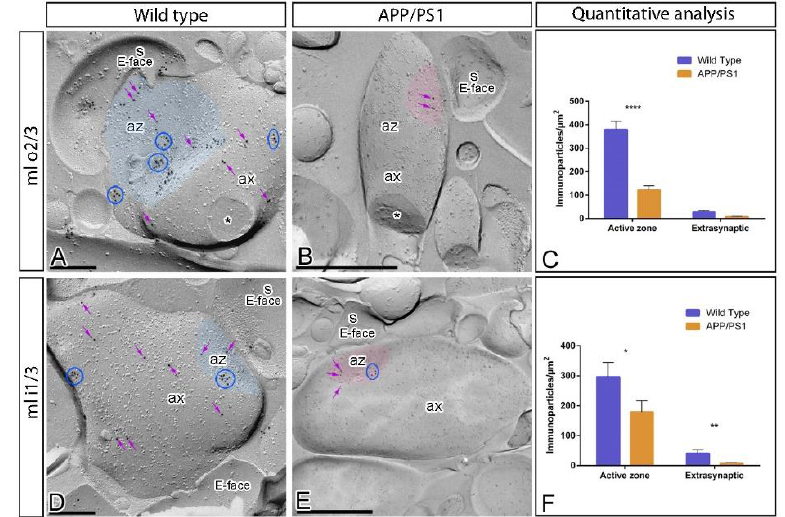
Figure 5. Presynaptic distribution of GABA B1 in the dentate gyrus in wild type and APP / PS1 mice. Electron micrographs showing immunoparticles for GABA B1 in presynaptic compartments in the outer two thirds (ml o2 / 3) and inner one third (ml i1 / 3) of the molecular layer of the DG at 12 months of